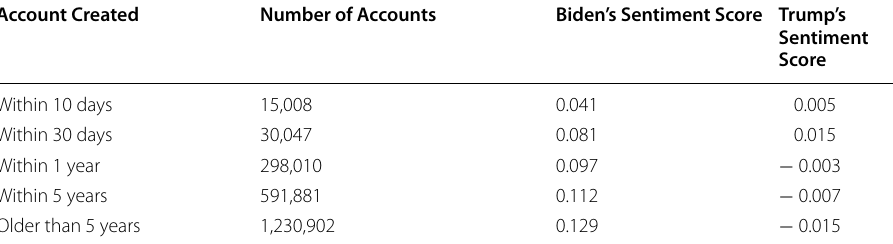
Table 1 Sentiment score of tweets per presidential candidate by groups of accounts based on when they were